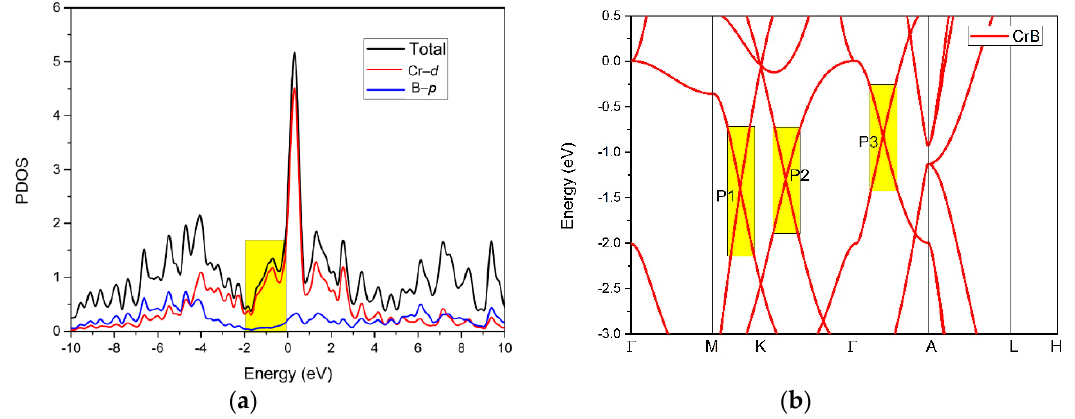
Figure 3. ( a ) The total and projected density of states (PDOS) of CrB 2 without considering the spin–orbit coupling (SOC) effect and ( b ) the calculated band structure of CrB 2 without SOC. The energy at the Fermi level was set to zero.